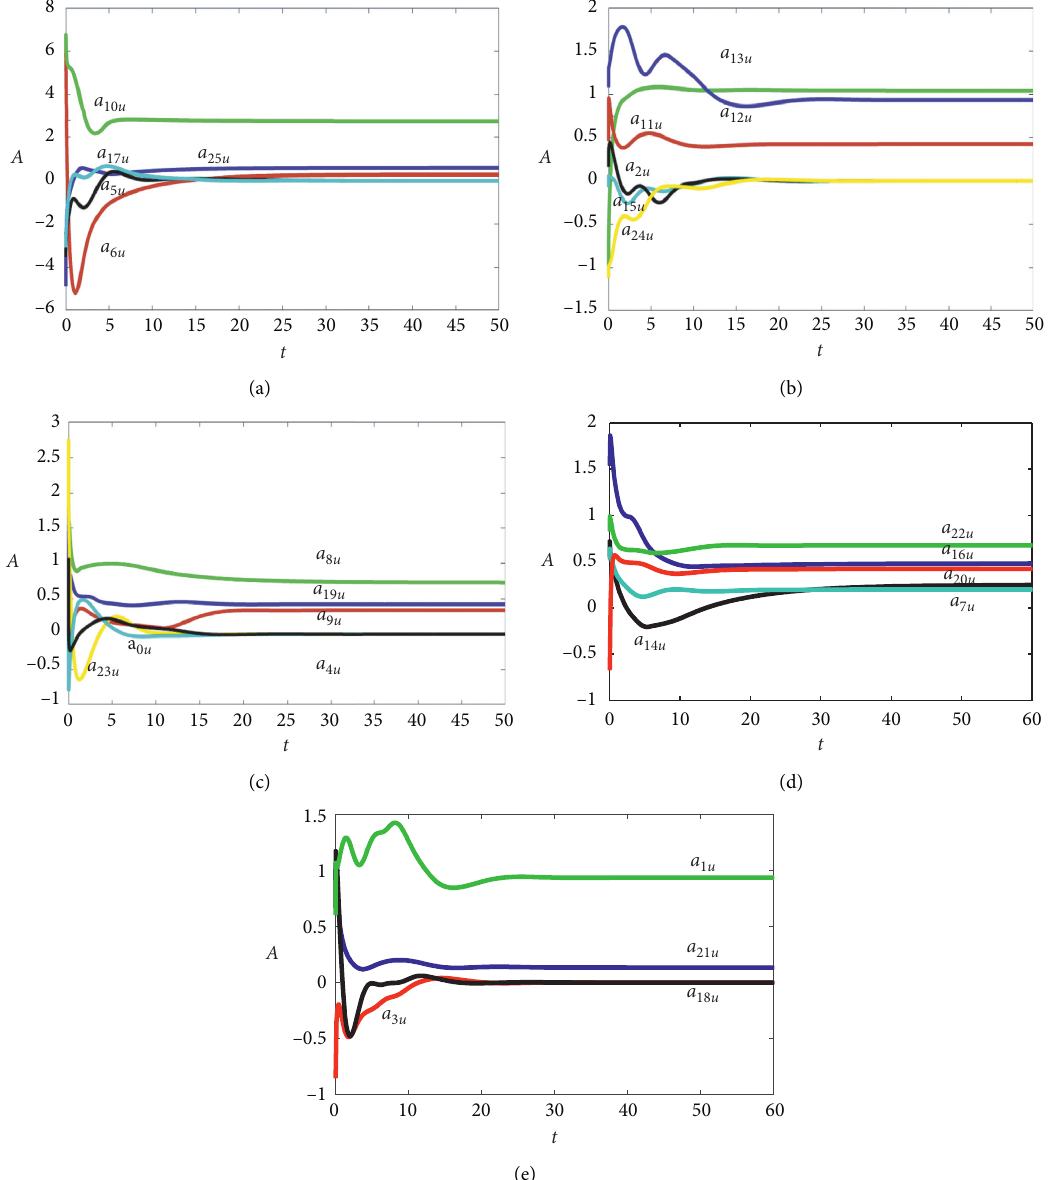
Figure 4: Transient behaviors of a